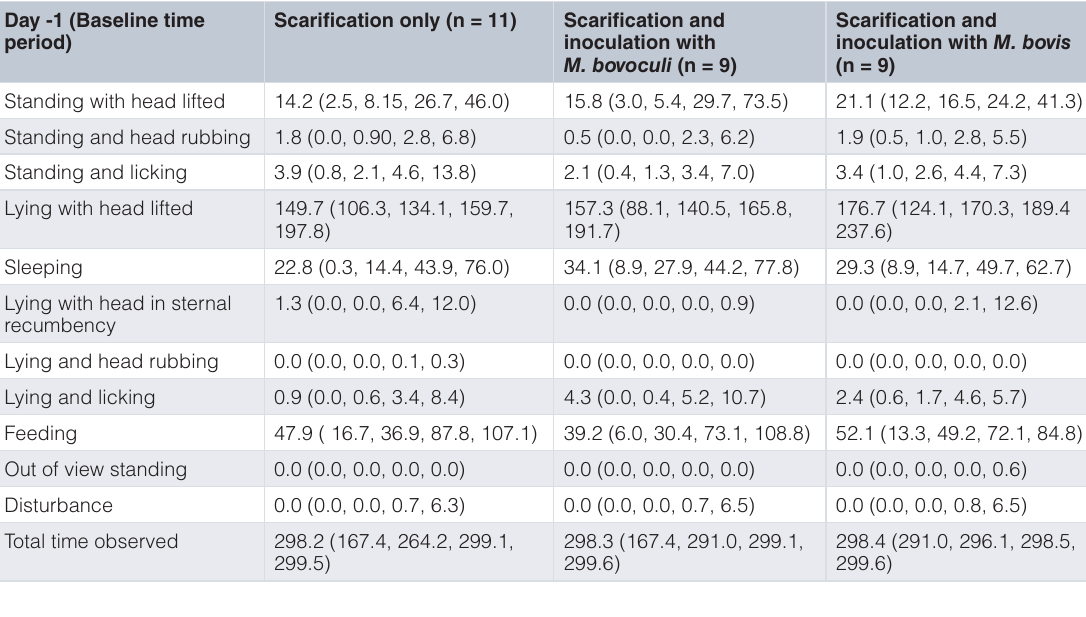
Table 3. Median, (minimum, 25 th quartile, 75 th quartile, maximum) values for duration of behavioral states in minutes by treatment during baseline time period (n = number of animals).